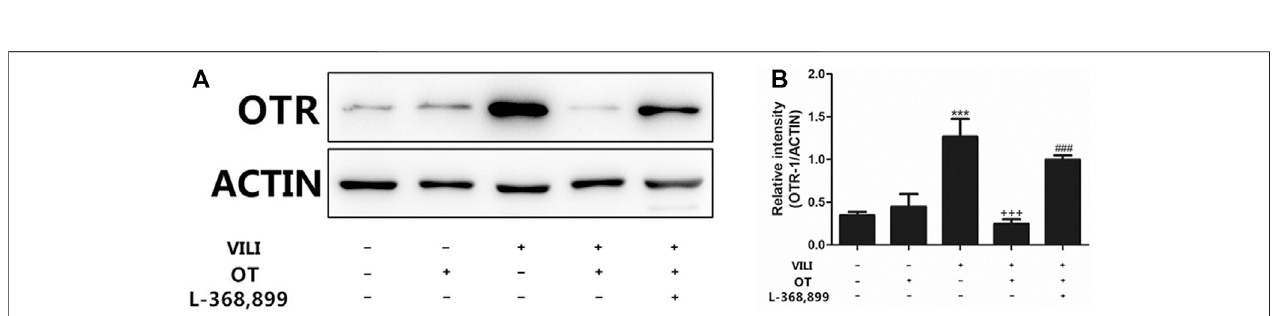
FIGURE 5| Effects ofoxytocin on the expression of OTRprotein.OT reduces the expression of OTR protein inthe mouse VILI model. Westernblot was performed to evaluate the protein expression of OTR in lung tissue (A) . The levels of OTR protein expression were quanti fi ed by measuring band intensities and displayed as fold increase relative to ACTIN (B) . The values are presented as means ± SD ( n (cid:2) 5). *** p < 0.001 compared with the Control and Control + OT groups, ### p < 0.001 compared with the VILI group, and +++ p < 0.001 compared with the OT + VILI group. OT, oxytocin; SD, standard deviation; VILI, ventilation-induced lung injury.